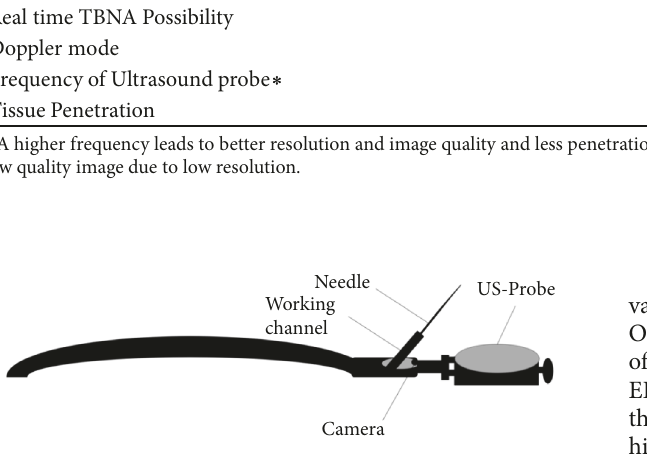
Figure 1: Schematic presentation of features of CP-EBUS equipped with video camera and needle for sampling and a convex ultrasound